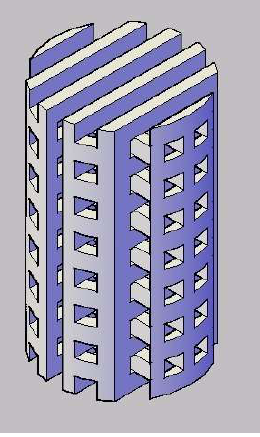
Figure 2. Design of 3D structure.